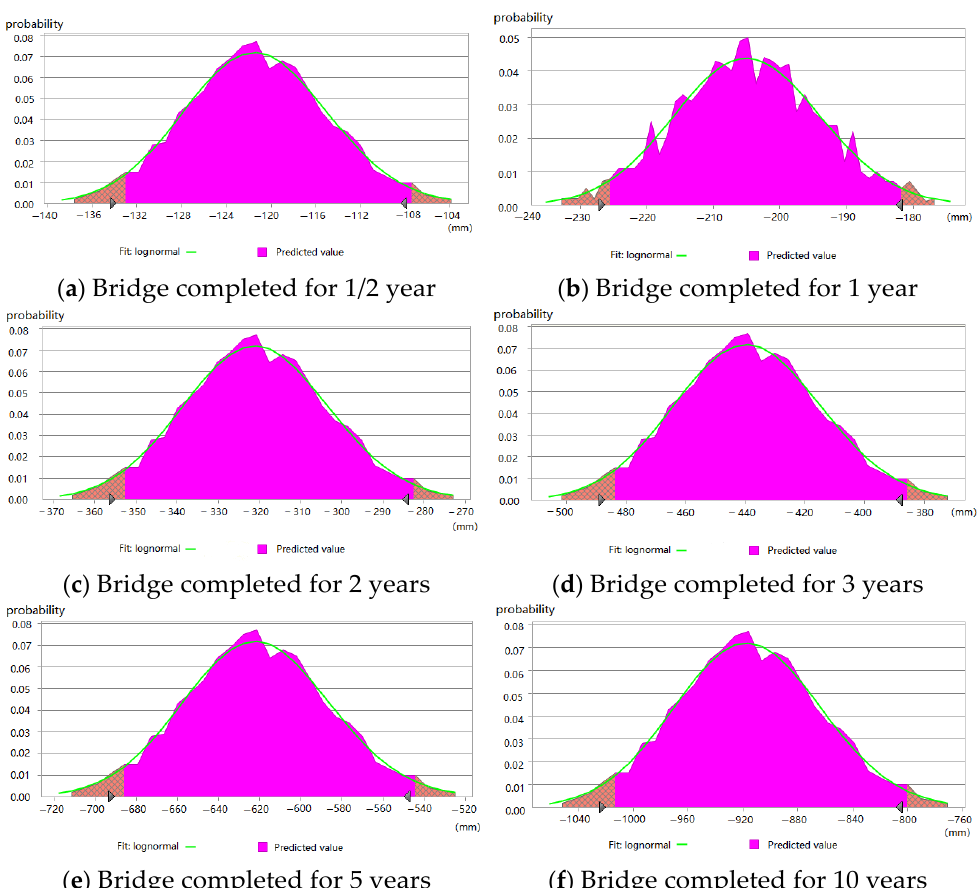
Figure 7. Probability distribution of vertical deformation at different time nodes. The vertical deformation predicted interval at each chosen time node for different random factors was plotted for these five different confidence levels. Figure 8 shows the results for the vertical deformation of different deformation intervals in 10 years.